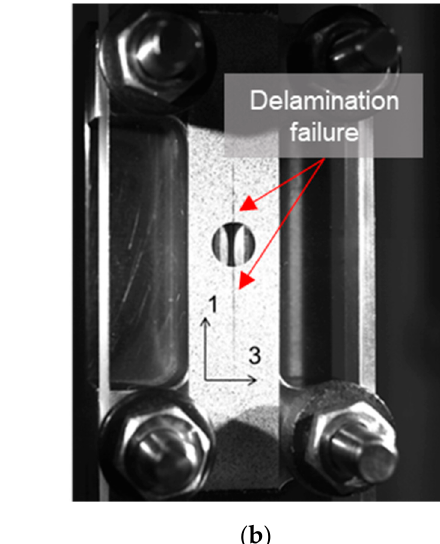
Figure 4. An example of ( a ) DIC-measured ILT strains prior to failure and ( b ) ILT delamination failure initiating at the 12 and 6 o’clock locations around the hole in a unidirectional IM7/8552 OHC specimen.